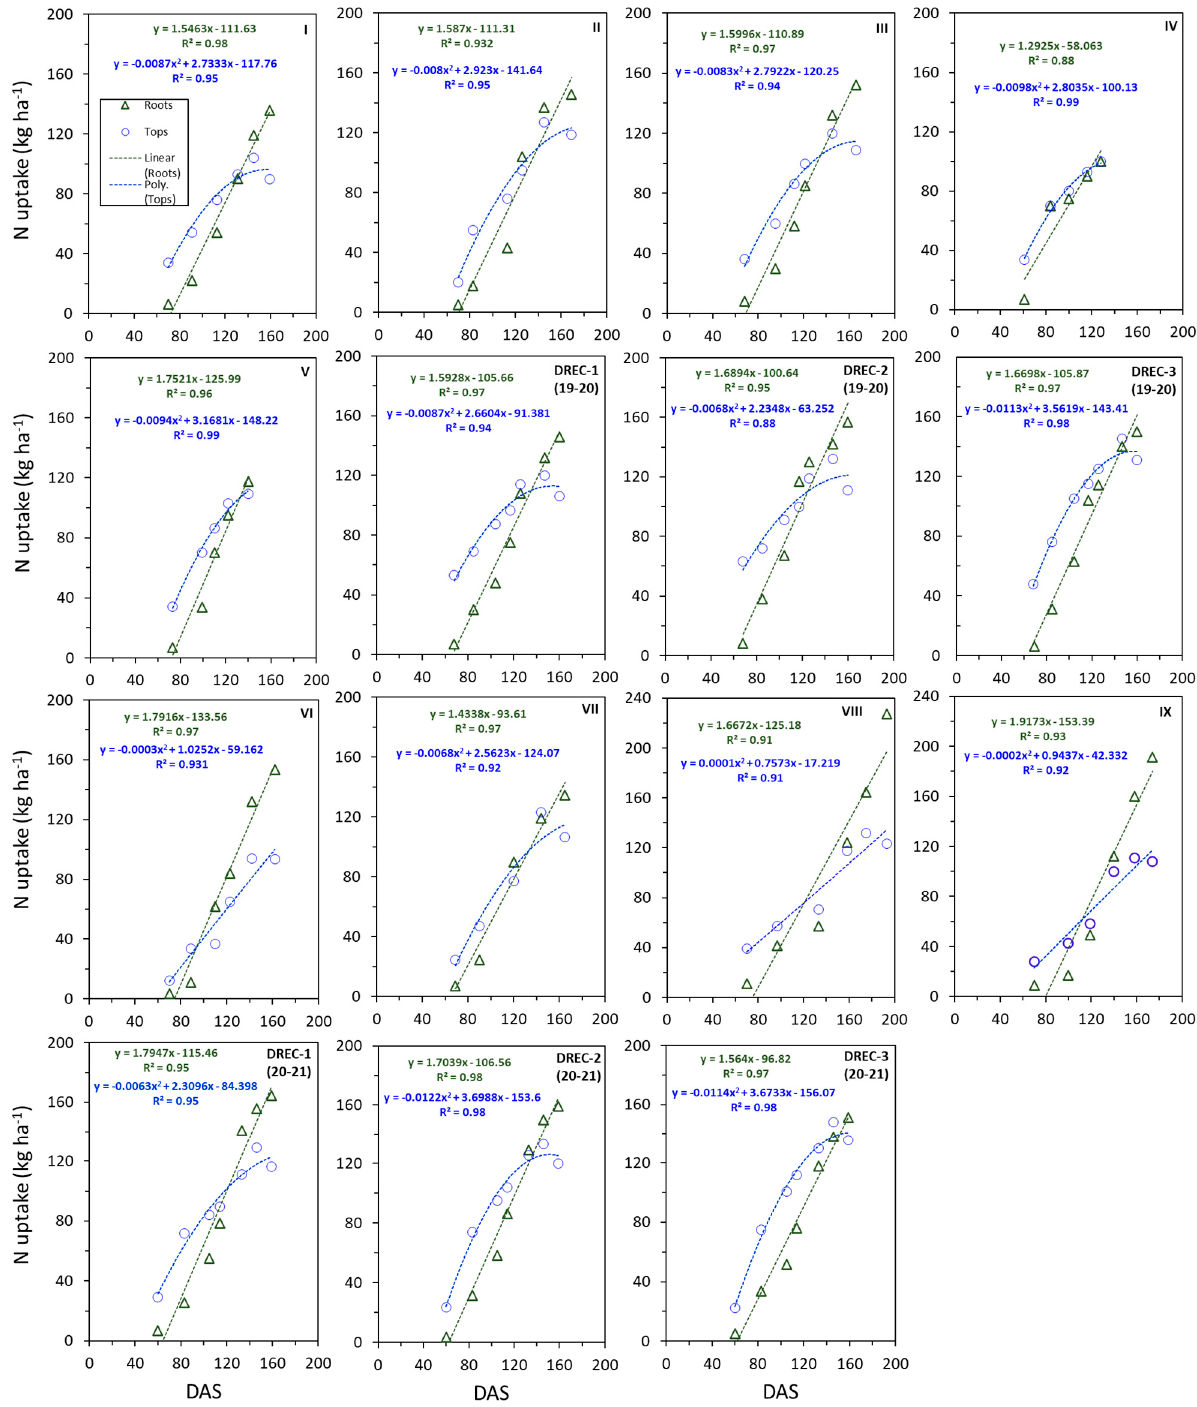
Figure 10. Total N accumulation during the growing season for tops and storage roots at the experimental sites. A significant linear trend was found between N uptake in tops and N application rates in both fresh-market and processing carrot fields (Table 6). However, no significant linear or quadratic regression was obtained between N application rates and both N accumulated in roots and total N uptake. Although the N accumulated in tops appeared to drop down or level off in most sites beyond 120 to 145 DAS, the N content decline occurred after DAS 155 at Sites VIII and XI with their longer growing